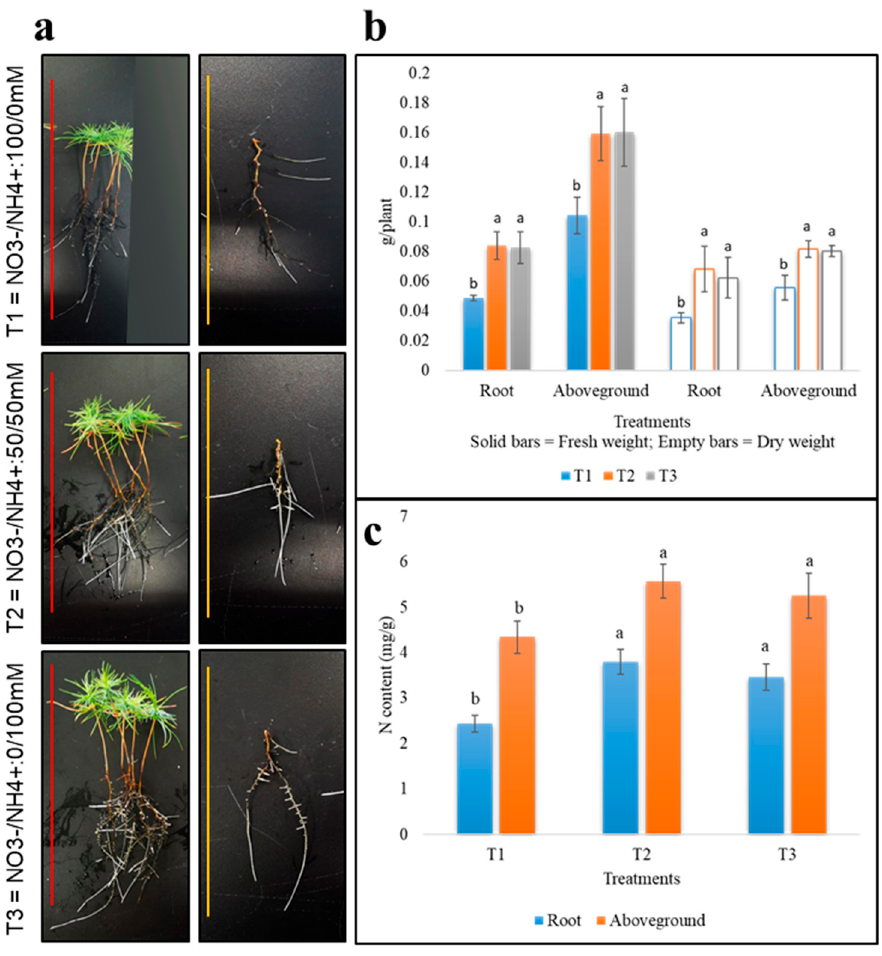
Figure 1. ( a ) Seedlings of Pinus massoniana treated with different N forms for 30 days. The red line = 20 cm, and the orange line = 15 cm. ( b ) Fresh and dry weight of roots and aboveground parts of seedlings. ( c ) Nitrogen content of roots and aboveground parts of the seedlings. Bars on the graphs show standard deviation. Different letters show that the values differ significantly between treatments.